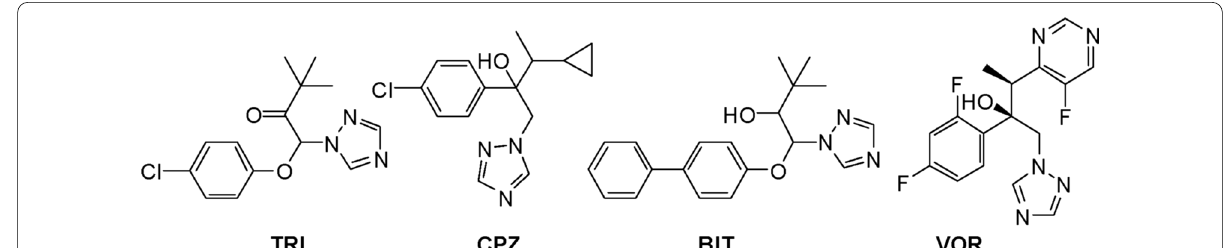
Fig. 1 Chemical structures of triadimefon (TDM), cyproconazol (CPZ), bitertanol (BIT) and voriconazole (VOR)